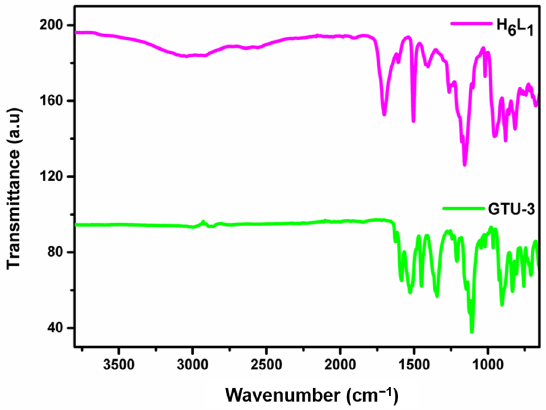
Figure 1. FTIR spectrum of the synthesized GTU-3 and H 6 L 1 .